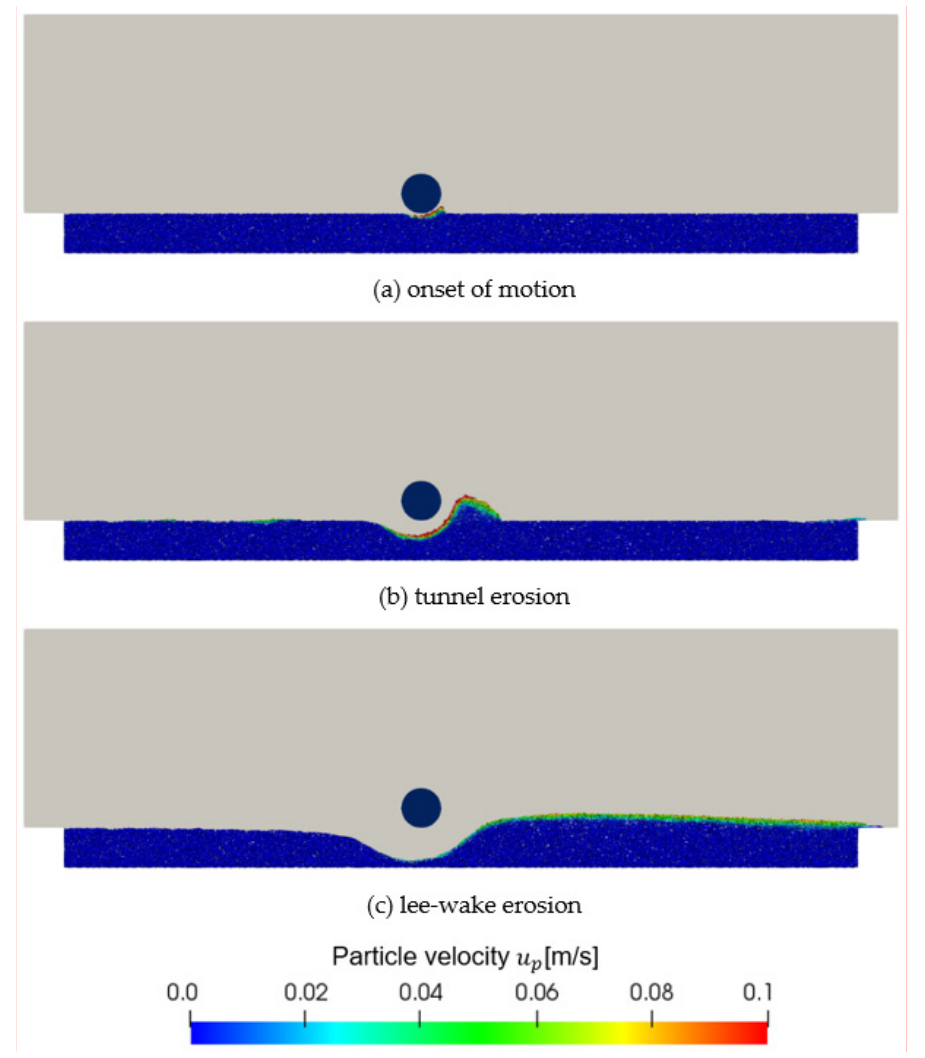
Figure 13. Velocity of particles.